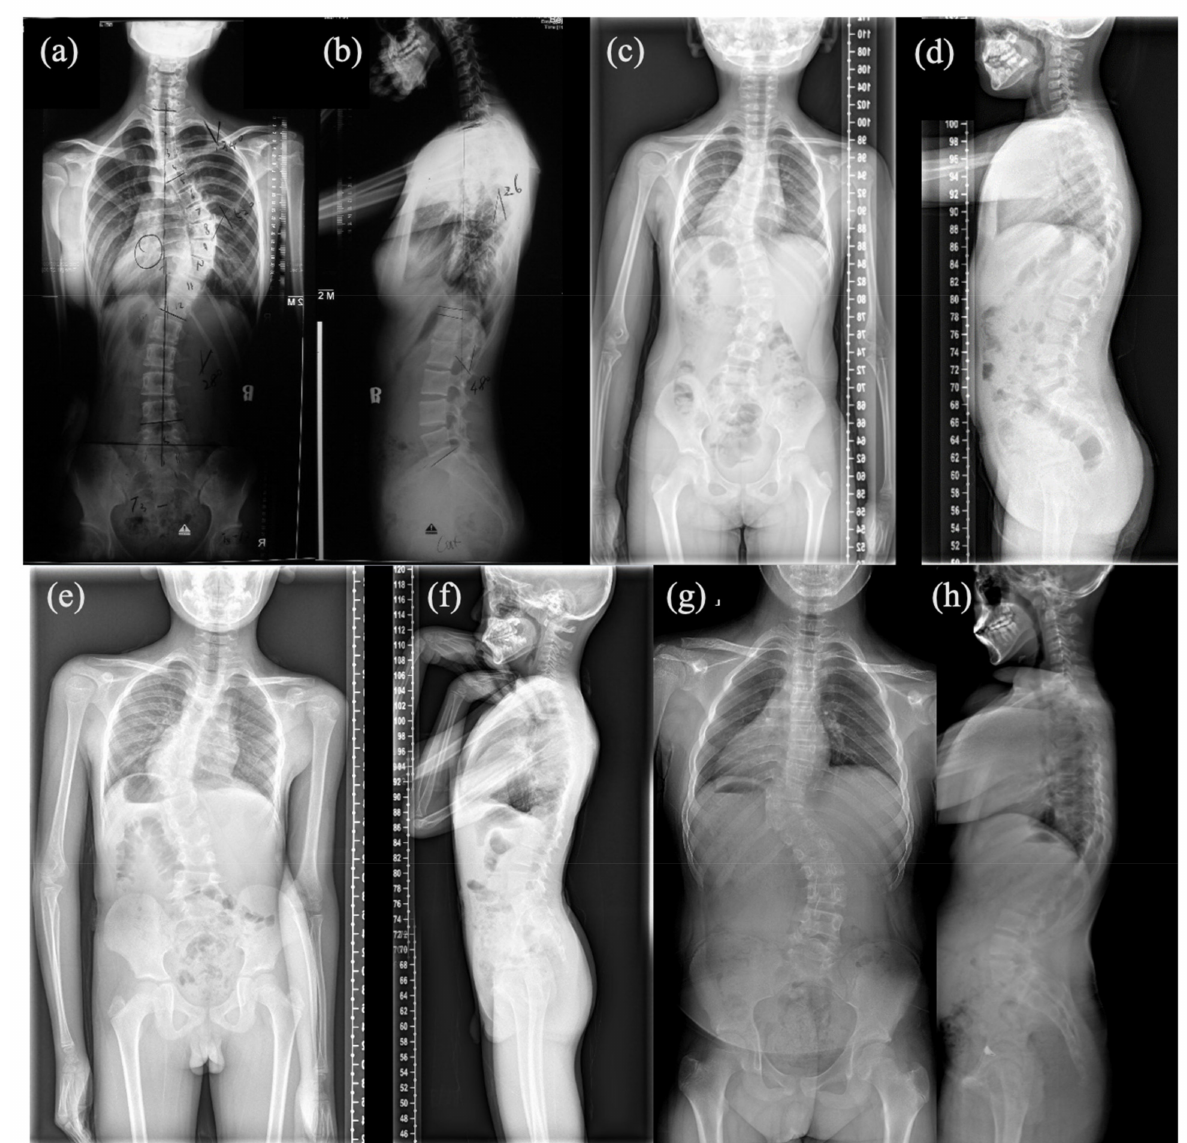
Figure 1. Anteroposterior and lateral spinal X-ray of four patients: ( a , b ) Anteroposterior and lateral spinal X-ray of patient #1; ( c , d ) Anteroposterior and lateral spinal X-ray of patient #2; ( e , f ) Anteroposterior and lateral spinal X-ray of patient #3; ( g , h ) Anteroposterior and lateral spinal X-ray of patient